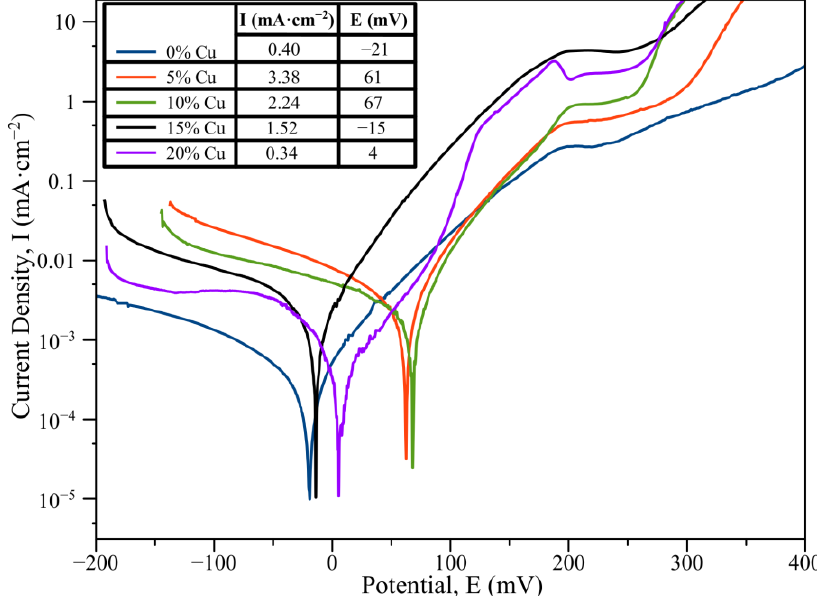
Figure 10. The polarization curves of CoCrCu x FeNi in 3.5% NaCl solution.